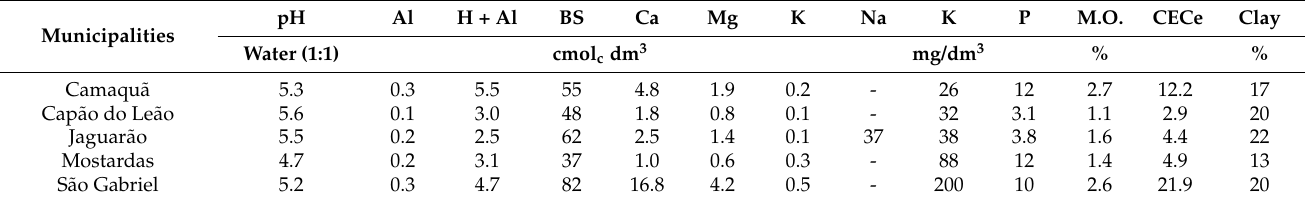
Table 4. Chemical and physical attributes of the soils (0–20 cm) of the validation